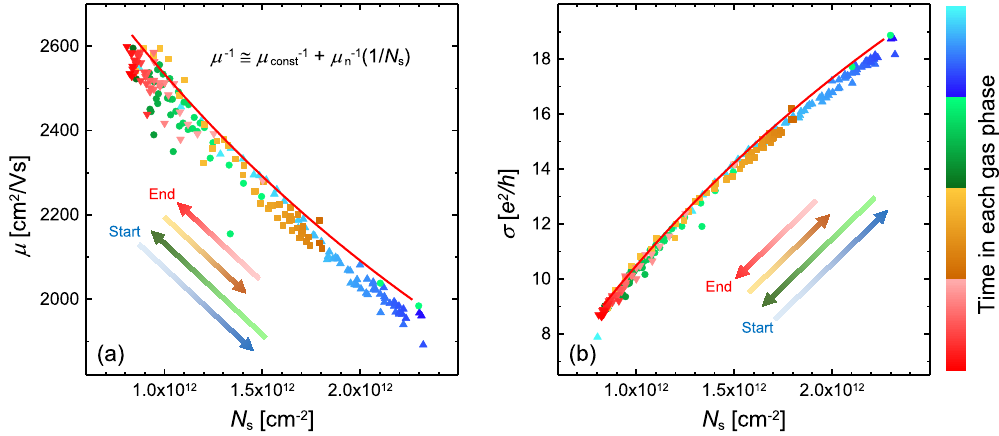
Figure 3. Panel (a) shows mobility μ versus sheet density N s for all data in Fig. 2. Panel (b) shows conductivity σ versus N s , where σ is expressed in quantum units ( e 2 / h ). Red lines show the best-match model fit for μ ( N s ) using the equation μ − 1 ≈ μ const − 1 + N s / a , where a is the constant fit parameter. Arrows indicate directions of time evolution. Colors and symbols identify phases of gas exposure as in Fig.